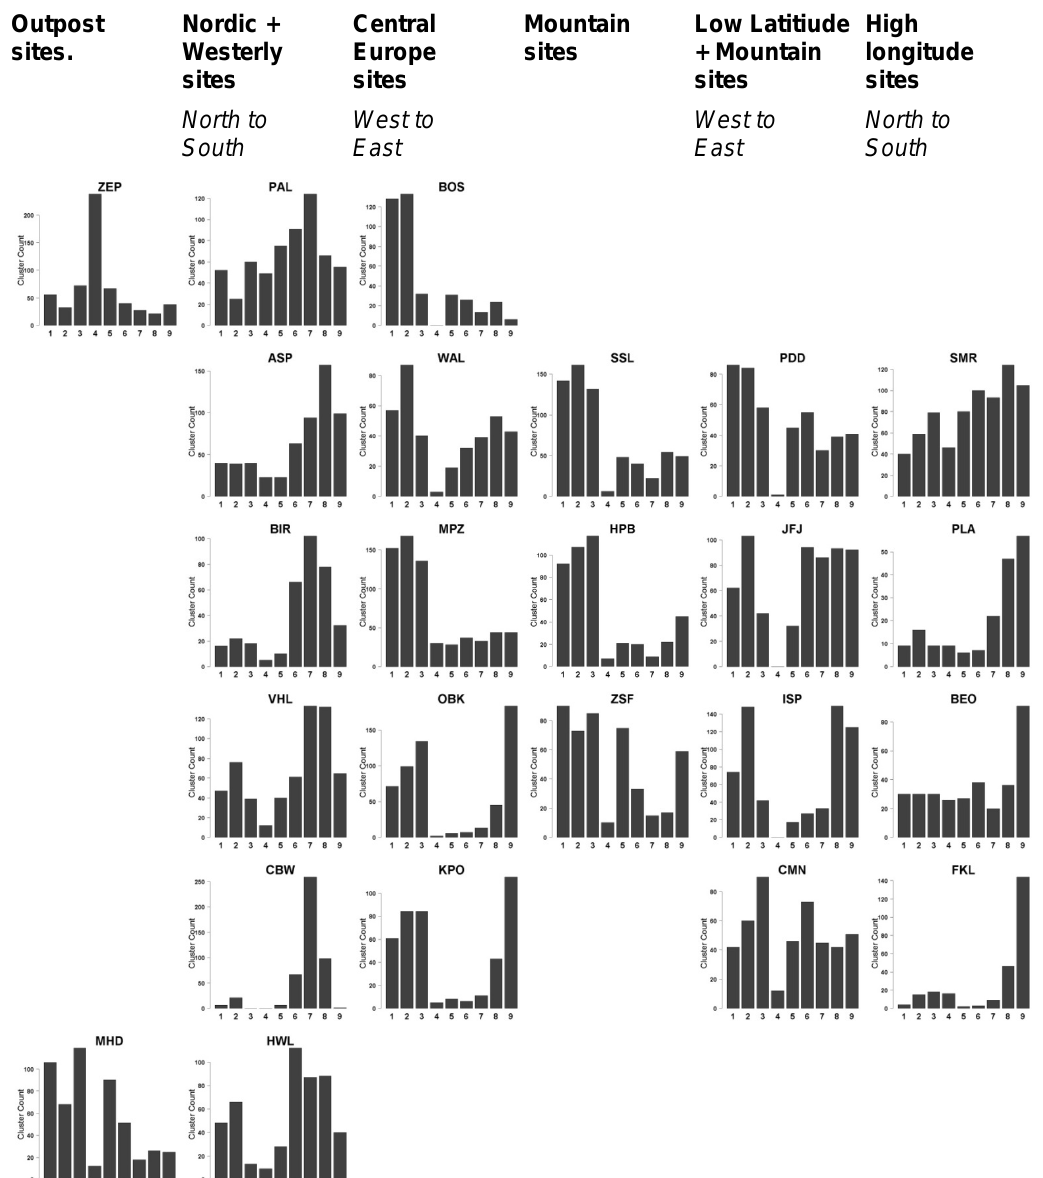
Fig. 3. Frequency of the clusters measured at each of the sites arranged in columns of similar